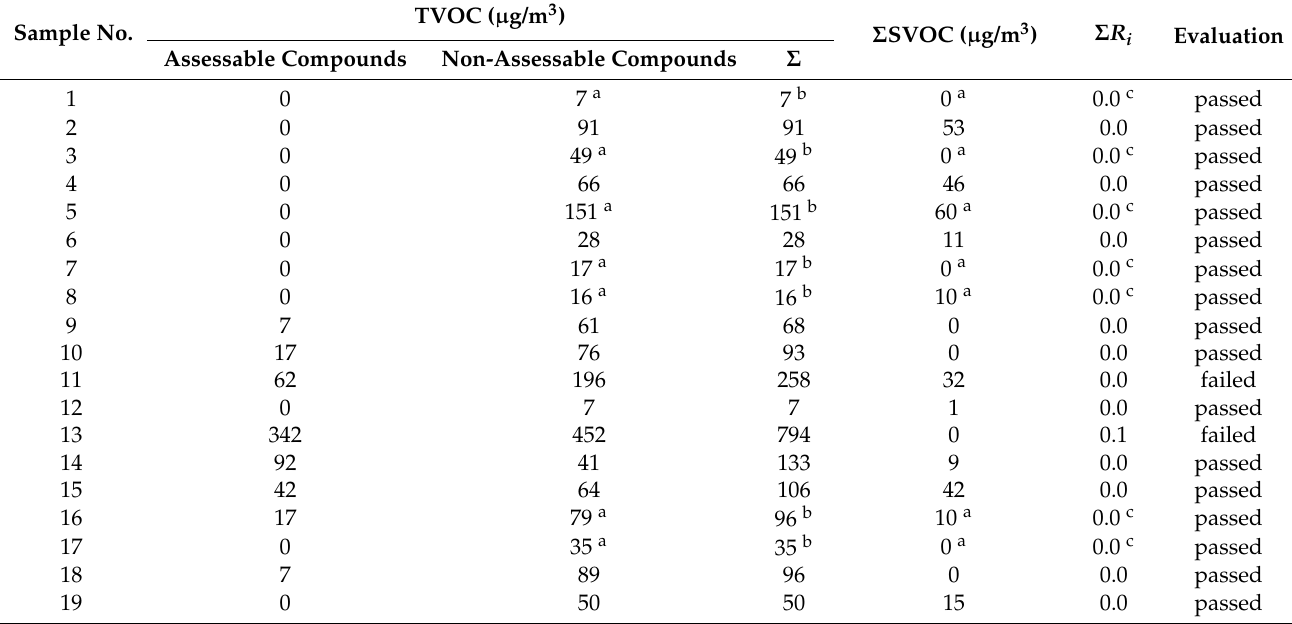
Table 3. Results of evaluation of investigated sample build-ups according to the AgBB scheme. Sample